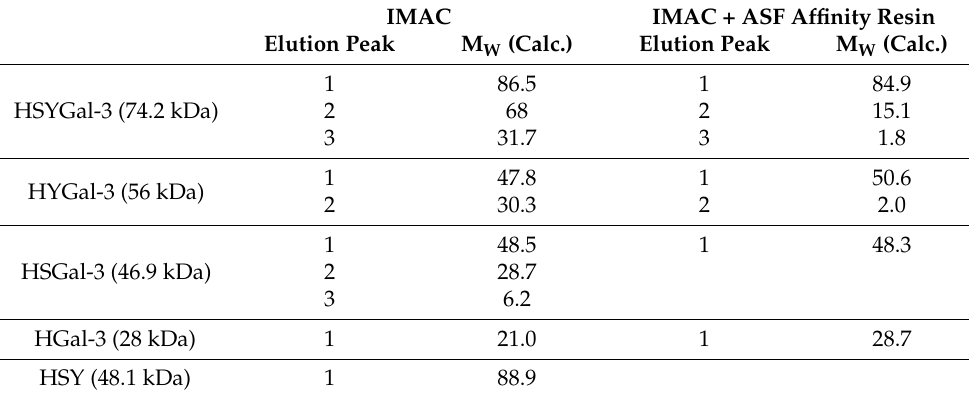
Table 1. Calculated molecular weight M W of eluted peaks of Gal-3 in size exclusion chromatography. Theoretic M w is given in brackets (see calibration of SEC column in Figure S13). IMAC IMAC + ASF Affinity Resin Elution Peak M W (Calc.) Elution Peak M W